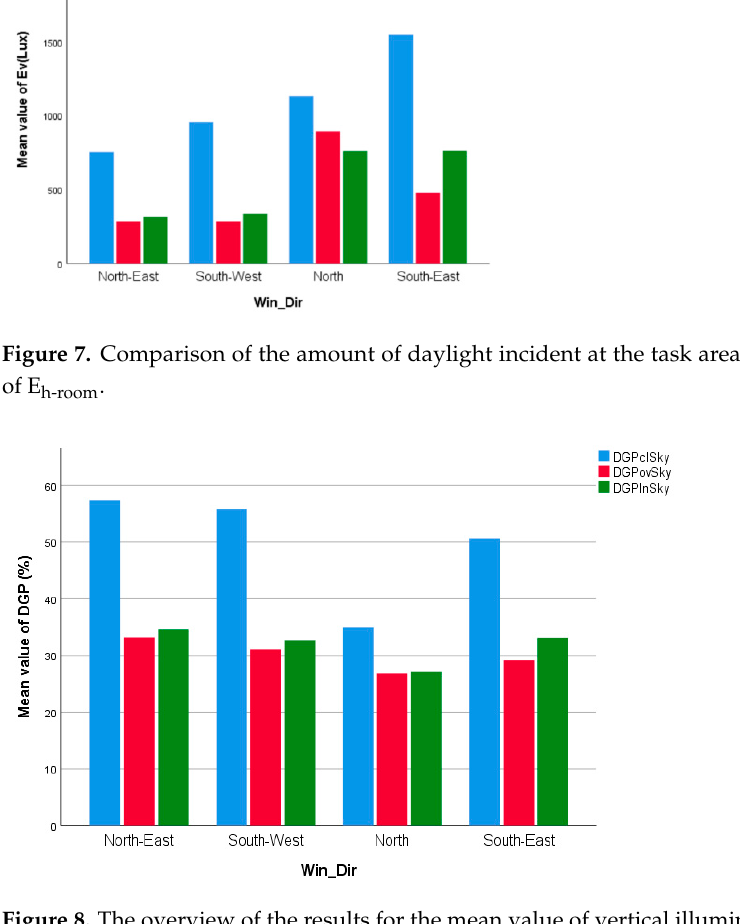
Figure 8. The overview of the results for the mean value of vertical illuminance in the center point Figure 9. DGP values under clear sky ( blue ), overcast sky ( red ), and intermediate sky ( green ) con- of each room with viewing direction towards the daylight opening of the ten rooms under three